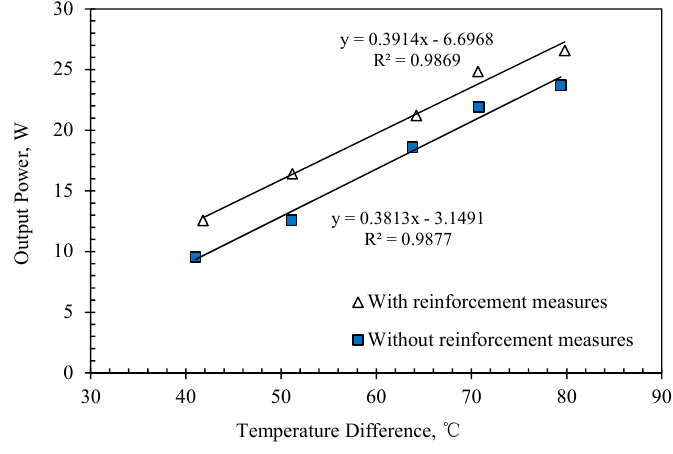
Figure 8. The effect of reinforcement measures on output power.